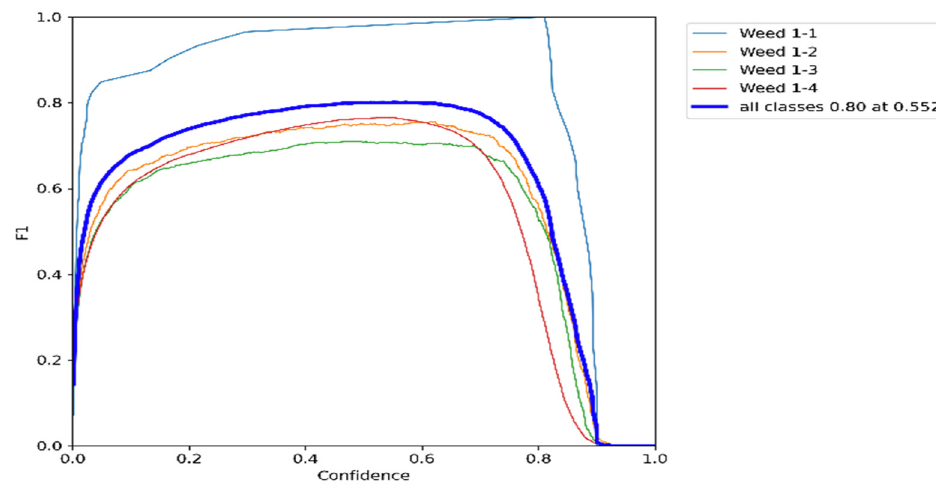
Figure 7. F1 score curve for Y L model.